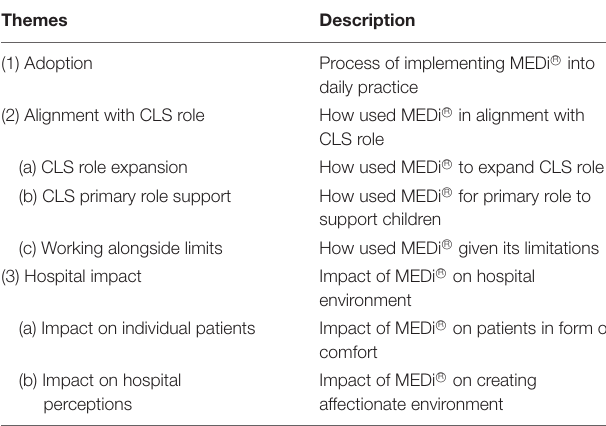
TABLE 1 | Summary of main and sub-themes. Themes